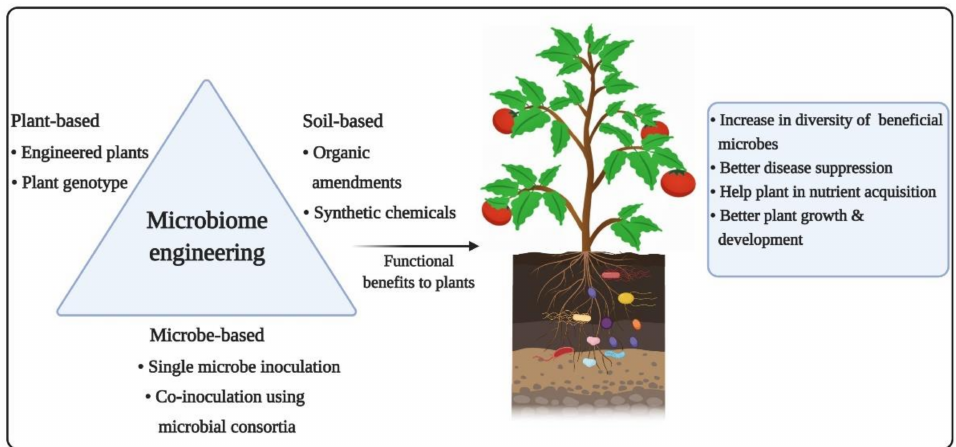
Figure 4. Different microbiome engineering approaches, such as cultivation of microbe-recruiting plant cultivars, inoculation of synthetic microbial communities, and conditioning of soil using suitable amendments, increase the diversity of functionally active and diverse microbial communities, resulting in improved plant health under adverse environmental